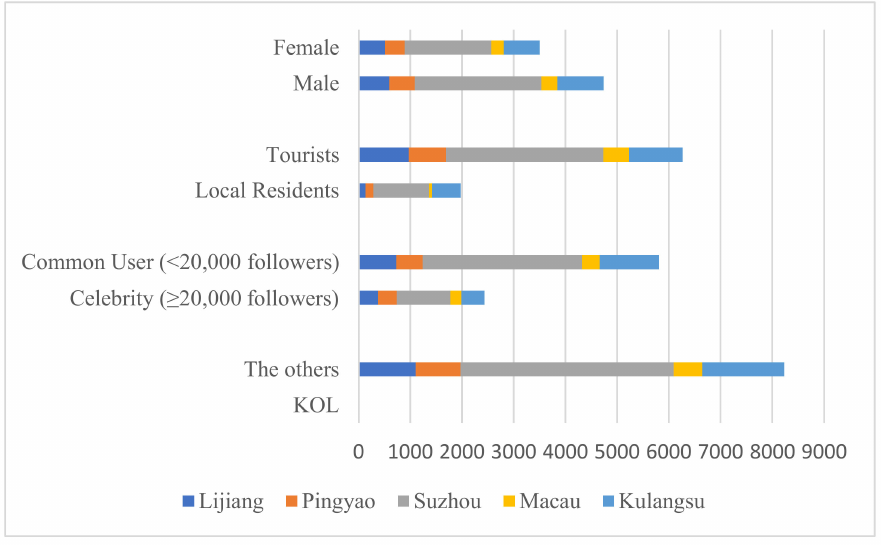
Figure 4. Components of Weibo users under the urban heritage conservation